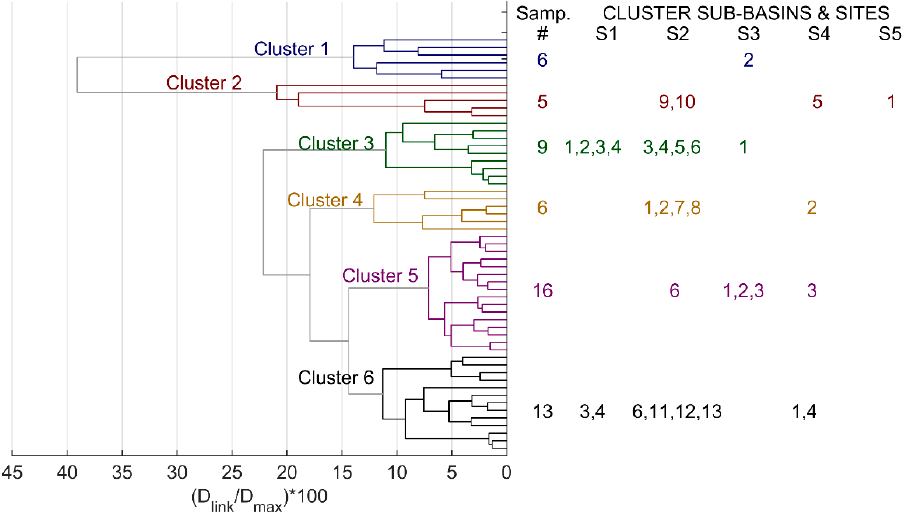
Figure 3. Cluster analysis dendrogram. Table 4. Clusters of sites with similar water quality.